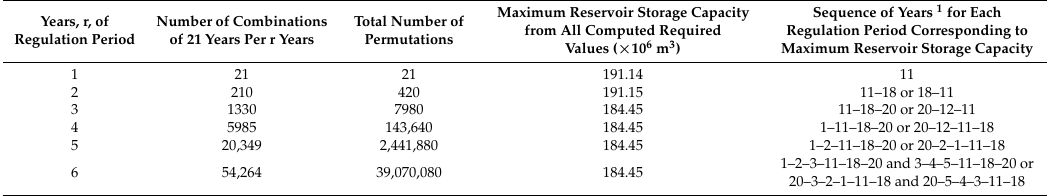
Table 5. Summary of results from the First Method.